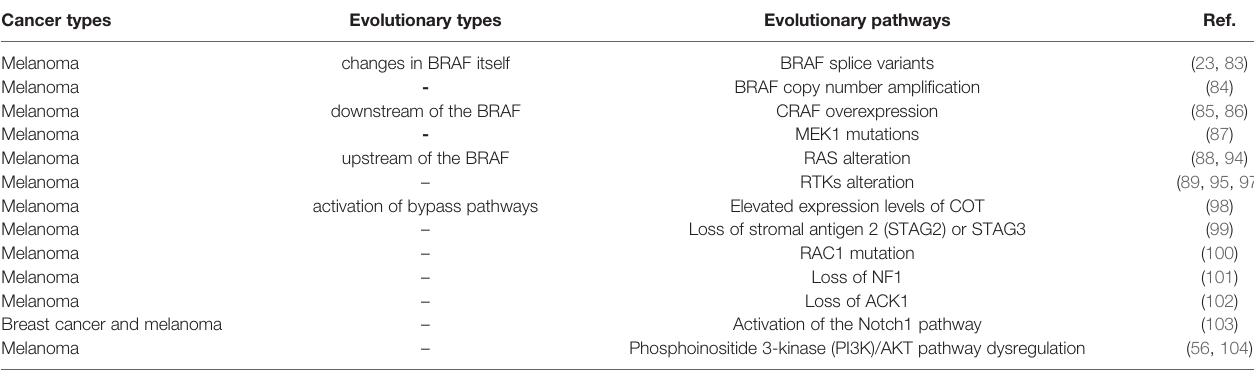
TABLE 2 | The evolution and pathways of BRAF